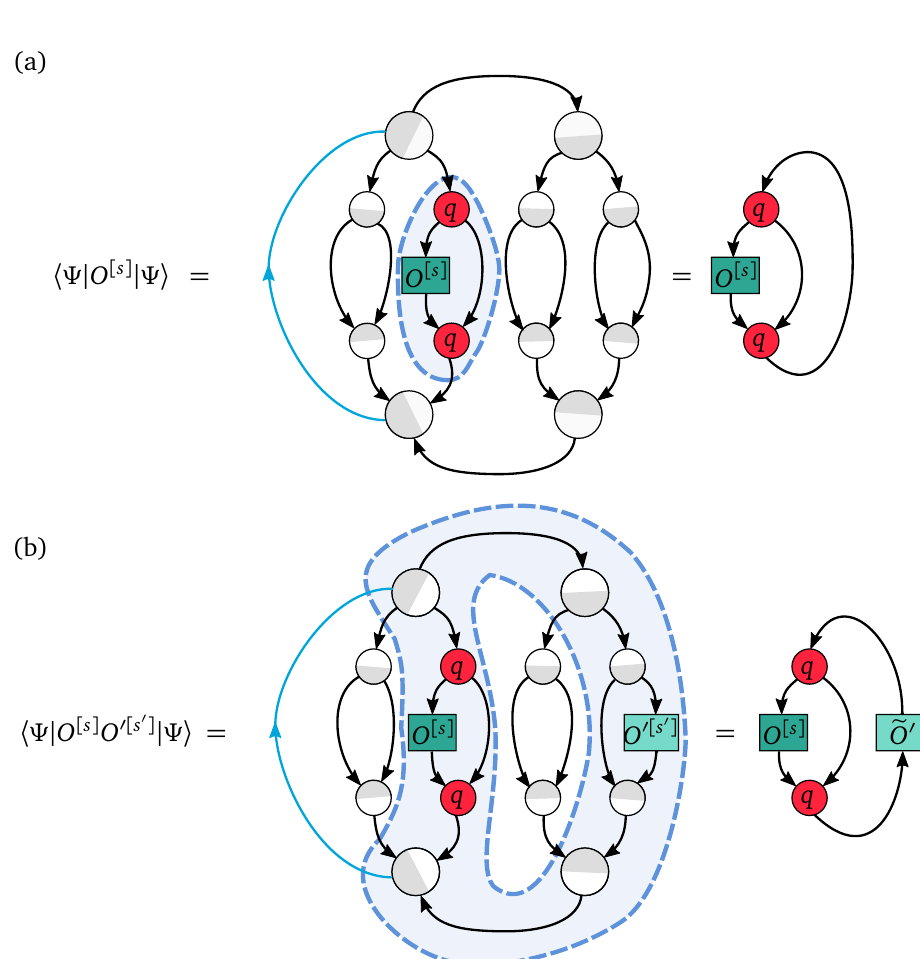
Figure 51: Evaluation of (a) a local and (b) a two-point observable expectation value or a binary TTN state | Ψ 〉 . The bra TN 〈 Ψ | is drawn as the vertically flipped version of the ket TN | Ψ 〉 , indicating hermitian conjugation of all its tensors. If the bTTN is properly gauged, the number of necessary contractions (involved tensors are N ) , highlighted) can be reduced to O ( 1 ) and O ( log 2